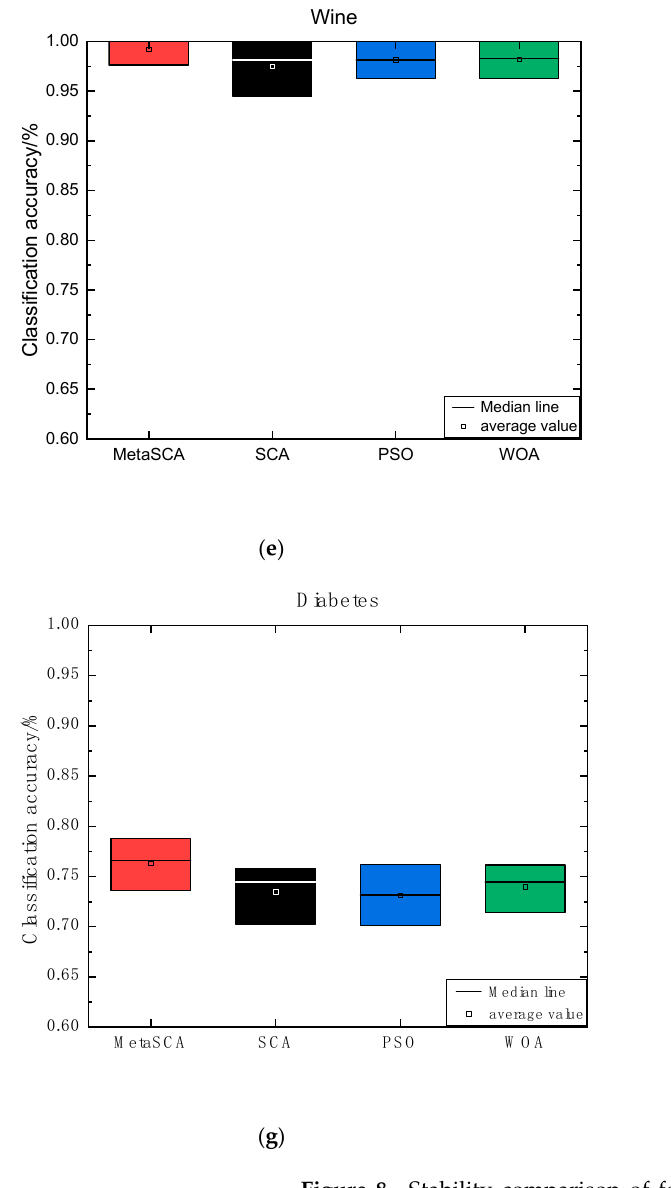
Figure 8. Stability comparison of feature selection models (KNN, neighbors = 3). ( a ) stability comparison on Sonar dataset; ( b ) stability comparison on Ionosphere dataset; ( c ) stability comparison on Vehicle dataset; ( d ) stability comparison on Cancer dataset; ( e ) stability comparison on Wine dataset; ( f ) stability comparison on WBDC dataset; ( g ) stability comparison on Diabetes dataset.